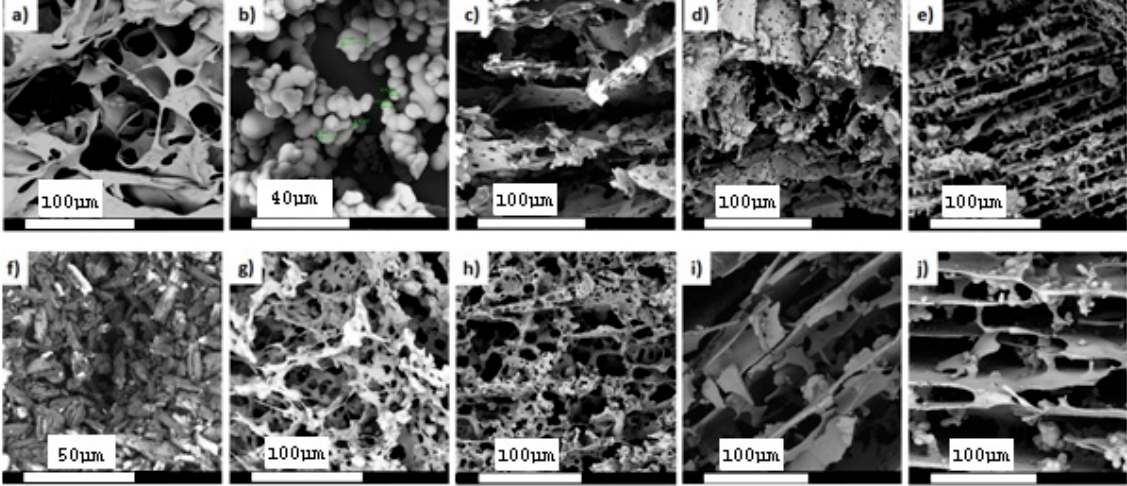
Figure 1. SEM images before immersion in Simulated Body Fluid (SBF) of ( a ) PCL/PAA blend; ( b ) silica microspheres; ( c ) PCL/PAA/S1 blend; ( d ) PCL/PAA/S2 blend; ( e ) PCL/PAA/S3 blend; ( f ) CFX; ( g ) PCL/PAA/CFX blend; ( h ) PCL/PAA/S1/CFX blend; ( i ) PCL/PAA/S2/CFX blend, and; ( j ) PCL/PAA/S3/CFX blend.